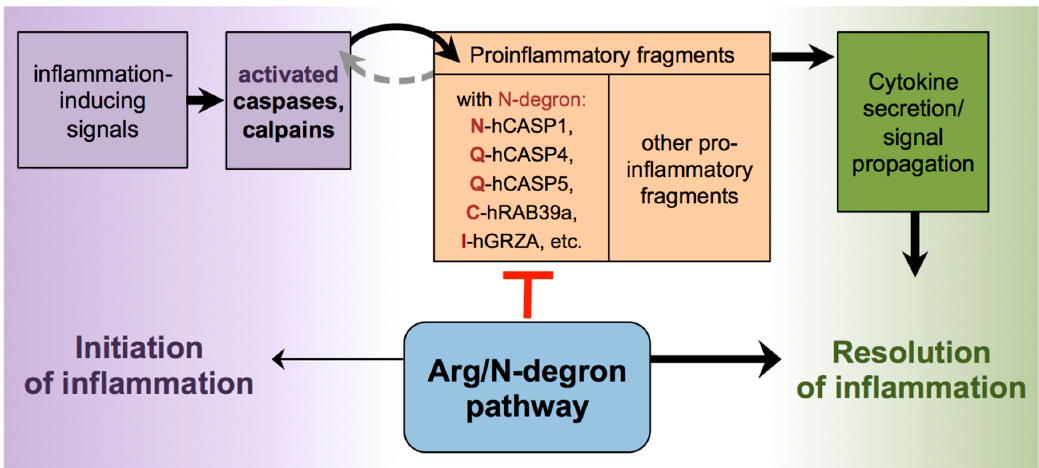
Figure 6. The Arg / N-degron pathway as a regulator of inflammation. Working model where the N-degron pathway regulates inflammation by the degradation of proinflammatory Arg / N-degron substrates (Asn-hCASP-1, Gln-hCASP-4, Gln-hCASP-5, Cys-RAB39a, Ile-GRZA, etc.). Selective degradation of proinflammatory protein fragments by the Arg / N-degron pathway could act as a control mechanism to prevent overstimulation of the immune system and to resolve inflammation.